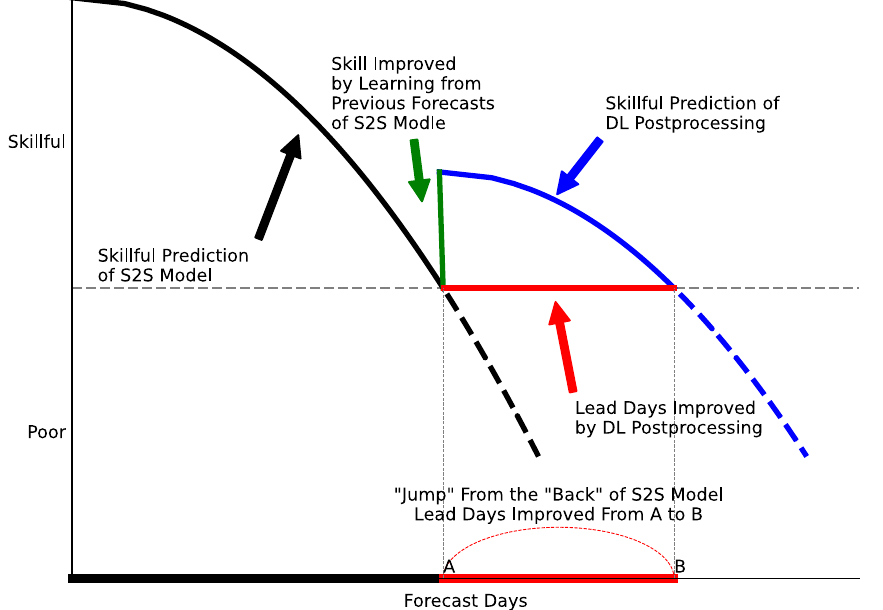
Figure 7. Schematic diagram for the DL approach improving the prediction skill of S2S operational